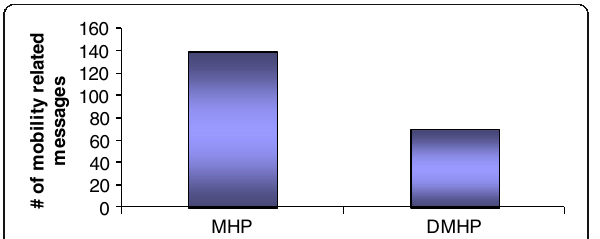
Fig. 15 Handover-related messages of the MHP and